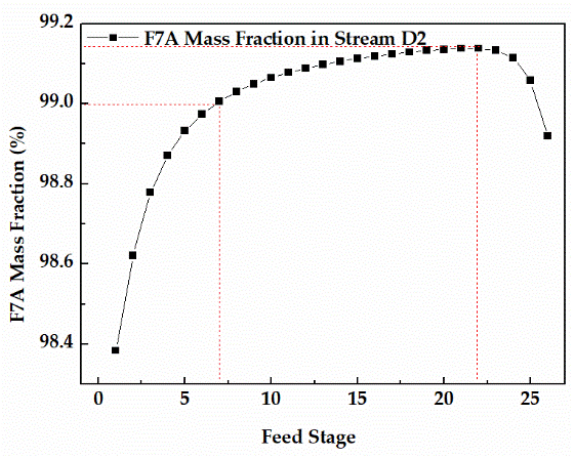
Figure 9. Effect of feed stage on F7A mass fraction in stream D2.